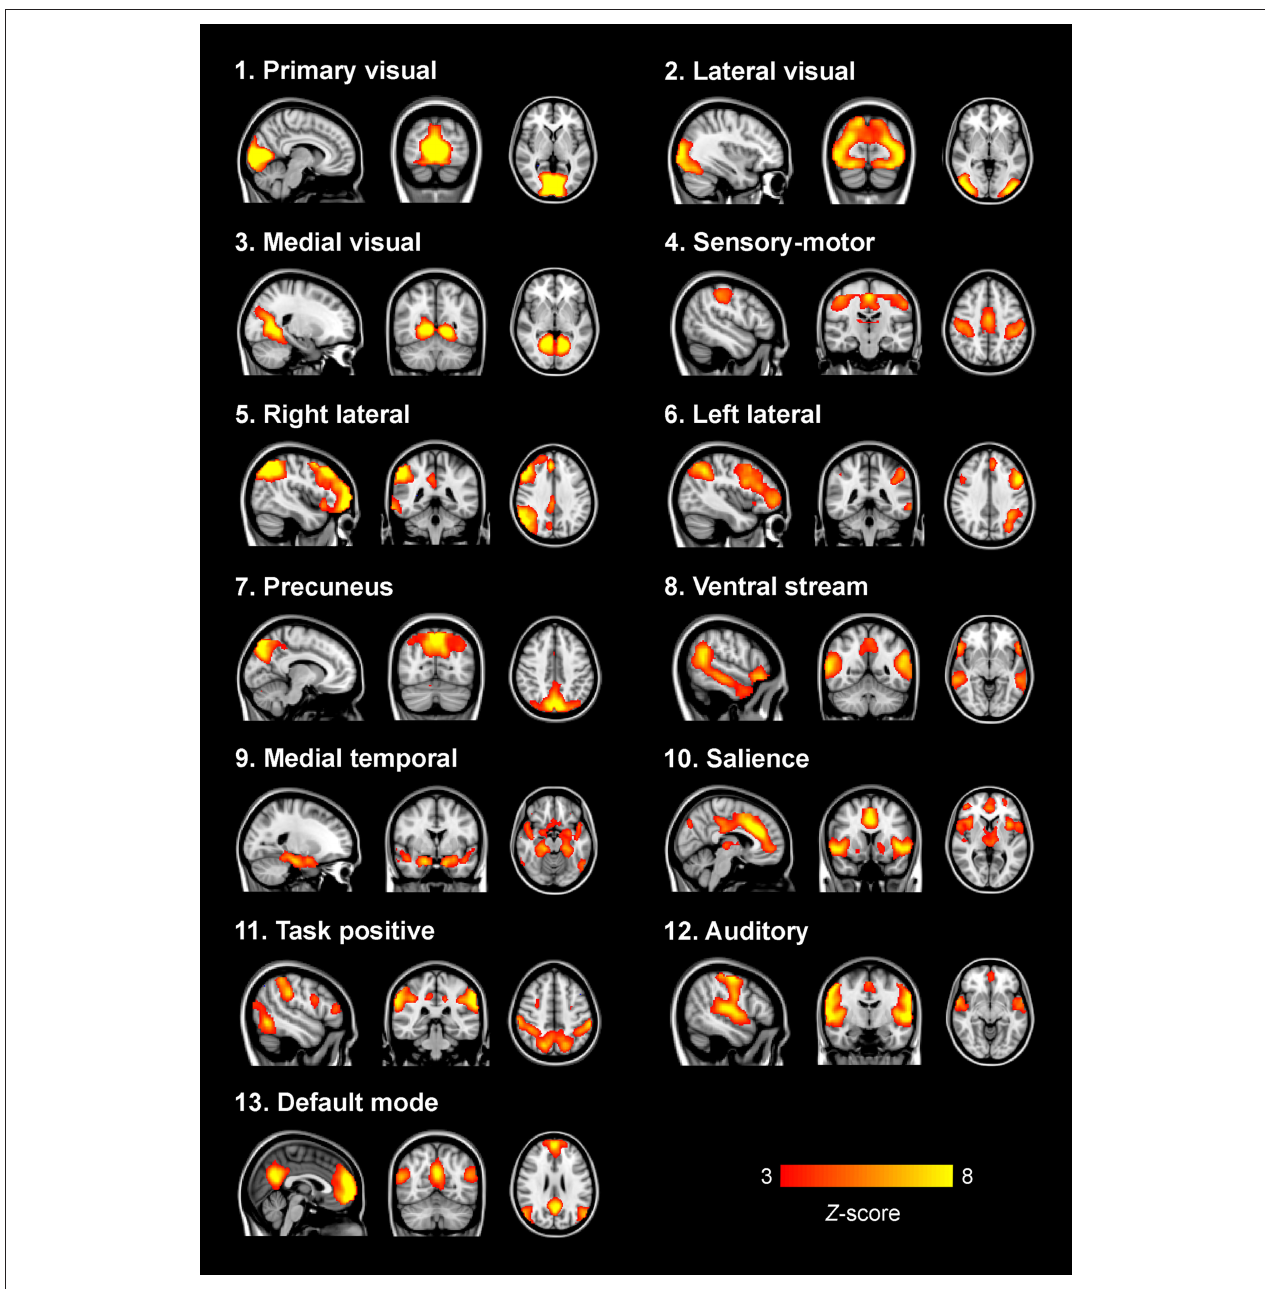
Damoiseaux et al., 2006) and show assemblies of regions associated with sensory processing, affective processing, and higher order cognitive processes. Images are z -statistics, ranging from 3 to 8, overlaid on the MNI-152 standard brain. The left hemisphere of the brain corresponds to the right side in this